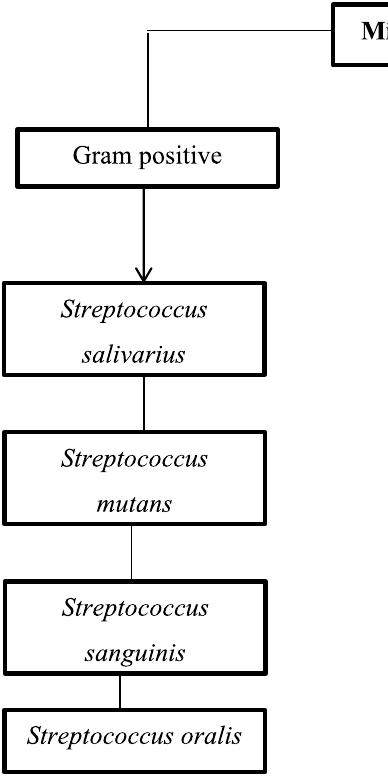
Fig. 2 Flowchart showing the different types of Microbes in saliva